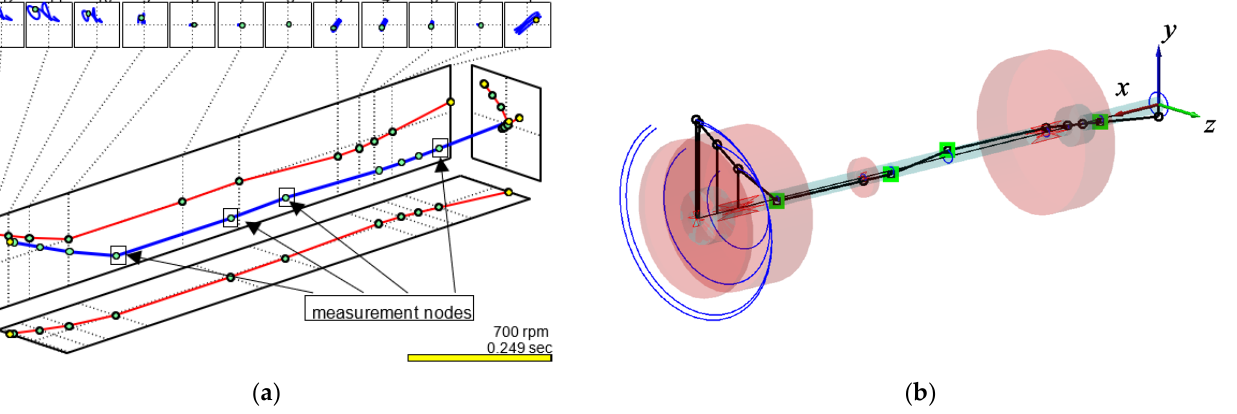
Figure 19. Kalman filter for prediction for the whole rotor ( a ) estimation value by Kalman, ( b ) simulated forward whirling mode of rotor at 700 rpm (green squares show the locations of bearings).